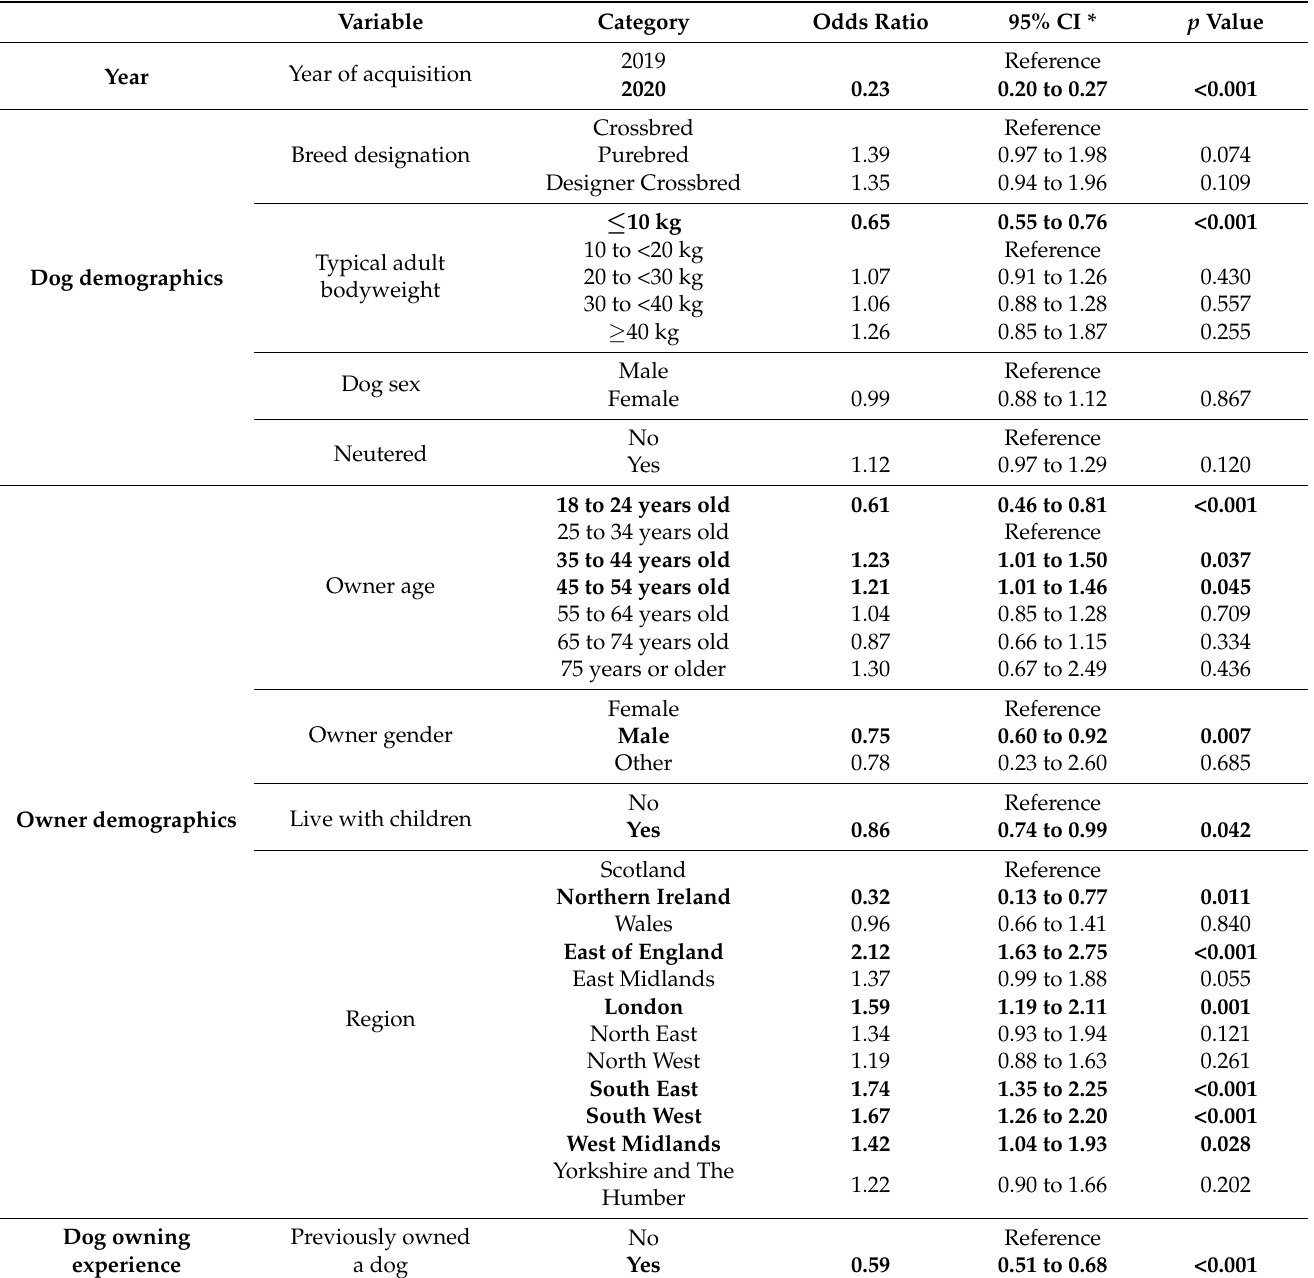
Table 11. Final multivariable logistic regression model for variables examined for association with attendance at either in-person or online puppy training classes under the age of 16 weeks ( n =